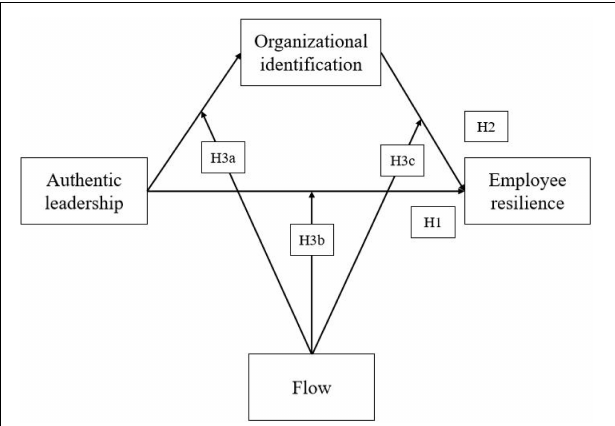
FIGURE 1 | The conceptual